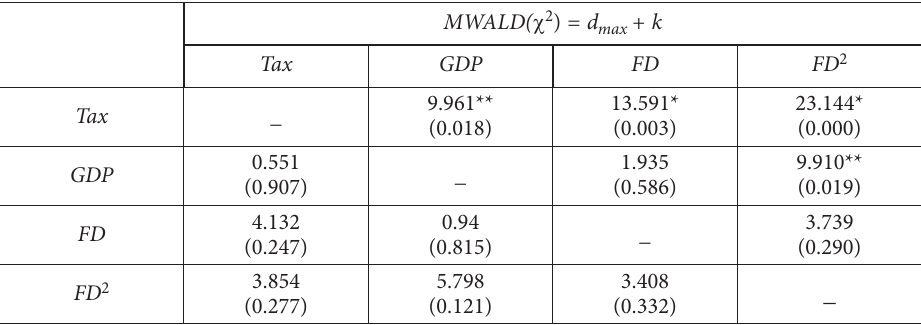
Table 10. Toda-Yamamoto Granger causality results with FD squared